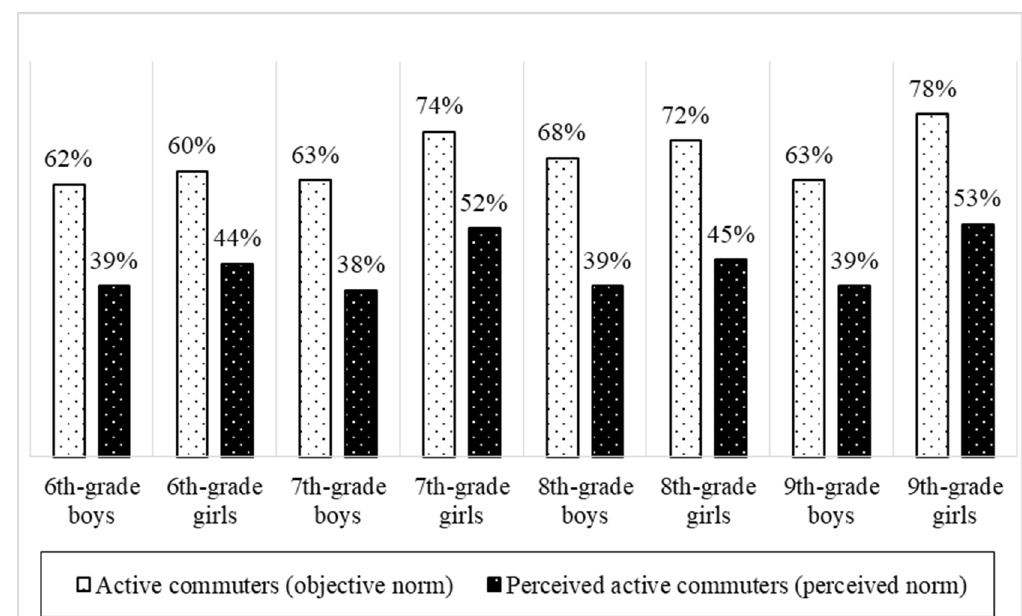
Figure 1. Misperceptions of the level of students commuting to school actively among Czech adolescents, according to gender and school grade.